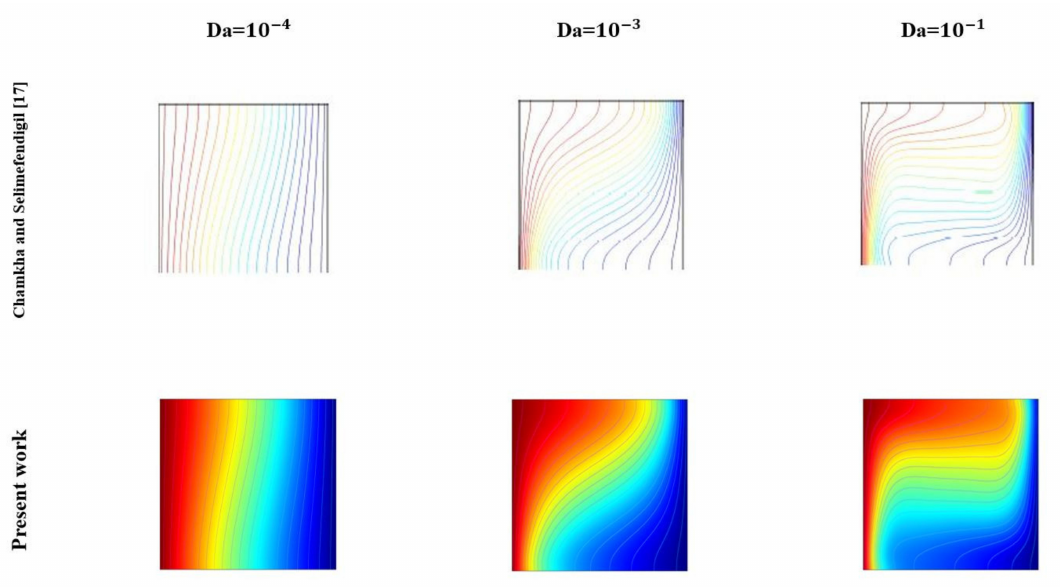
Figure 4. Isotherms for di ff erent Darcy numbers with Grashof number Gr = 10 4 , Ha = 10 and ϕ = 0.02. The analysis is performed for a constant Prandtl number value of 151 and the e ff ects of the